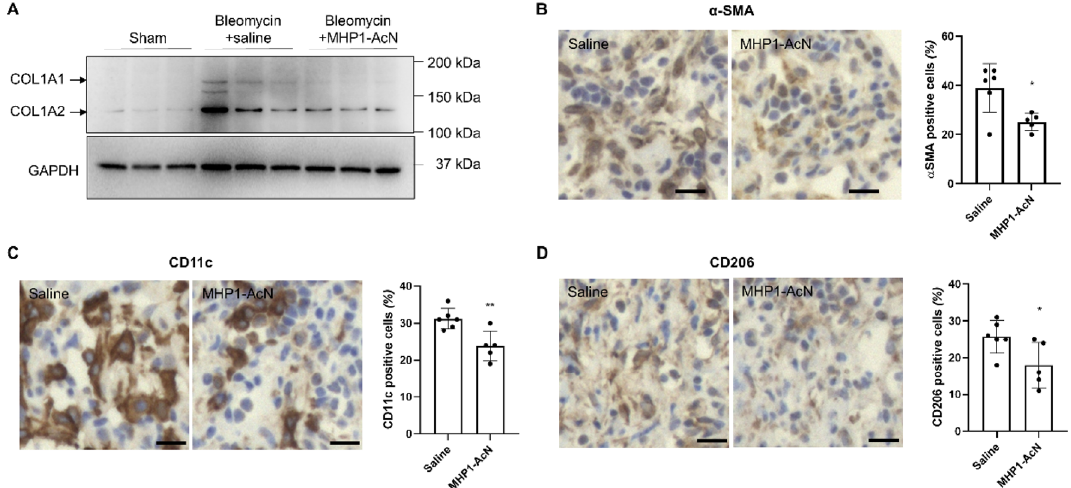
Figure 3. MHP1-AcN prevented the progression of bleomycin-induced lung fibrosis. ( A ) Representative western blotting images of COL1A1 and COL1A2 levels in lungs of mice. Representative images and quantification of α-SMA ( B ), CD11c ( C ) and CD206 ( D ) expression in the lungs of mice by immunohistochemistry staining. Bar = 25 µm. * p < 0.05, ** p < 0.01 vs saline-treated